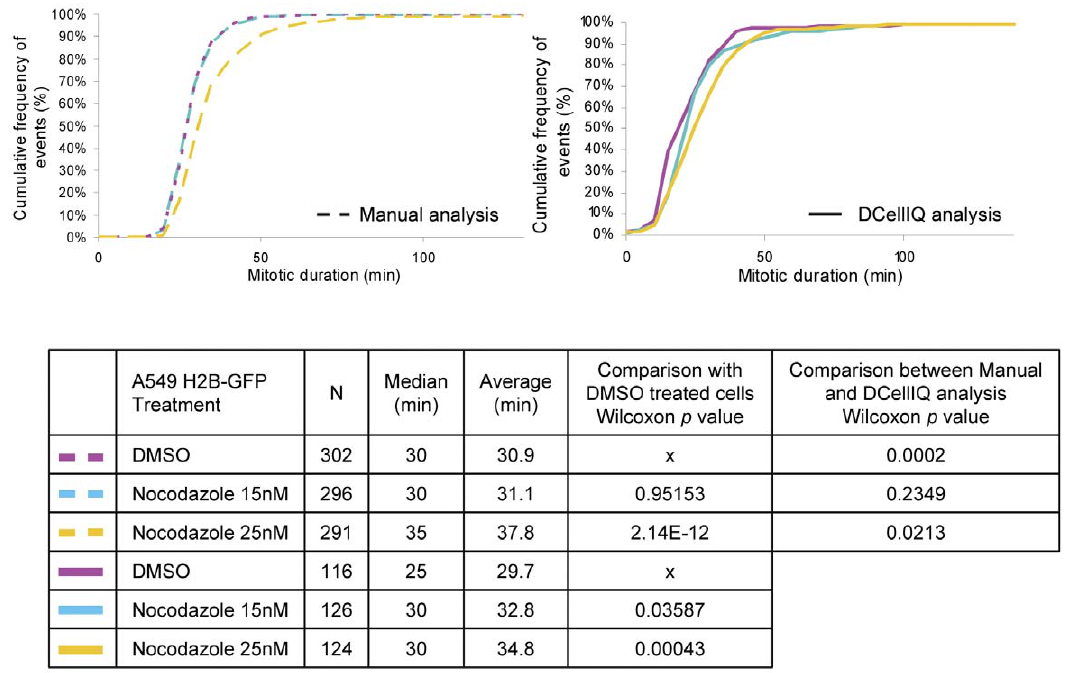
Figure 4. TSA detects small increases in mitotic duration when the spindle assembly checkpoint is activated by nocodazole in another cell line. A549 H2B-GFP cells treated with indicated concentrations of nocodazole or vehicle were imaged every 5 min for 48 hours. Half of the resulting image series were analyzed manually to identify the duration between the first frame of mitotic entry and the first frame of anaphase for all cells in the field. All image series were analyzed by DC ELL IQ using the time series approach. For each condition, 4 fields in 2 independent wells were imaged and the results for the image series were combined.